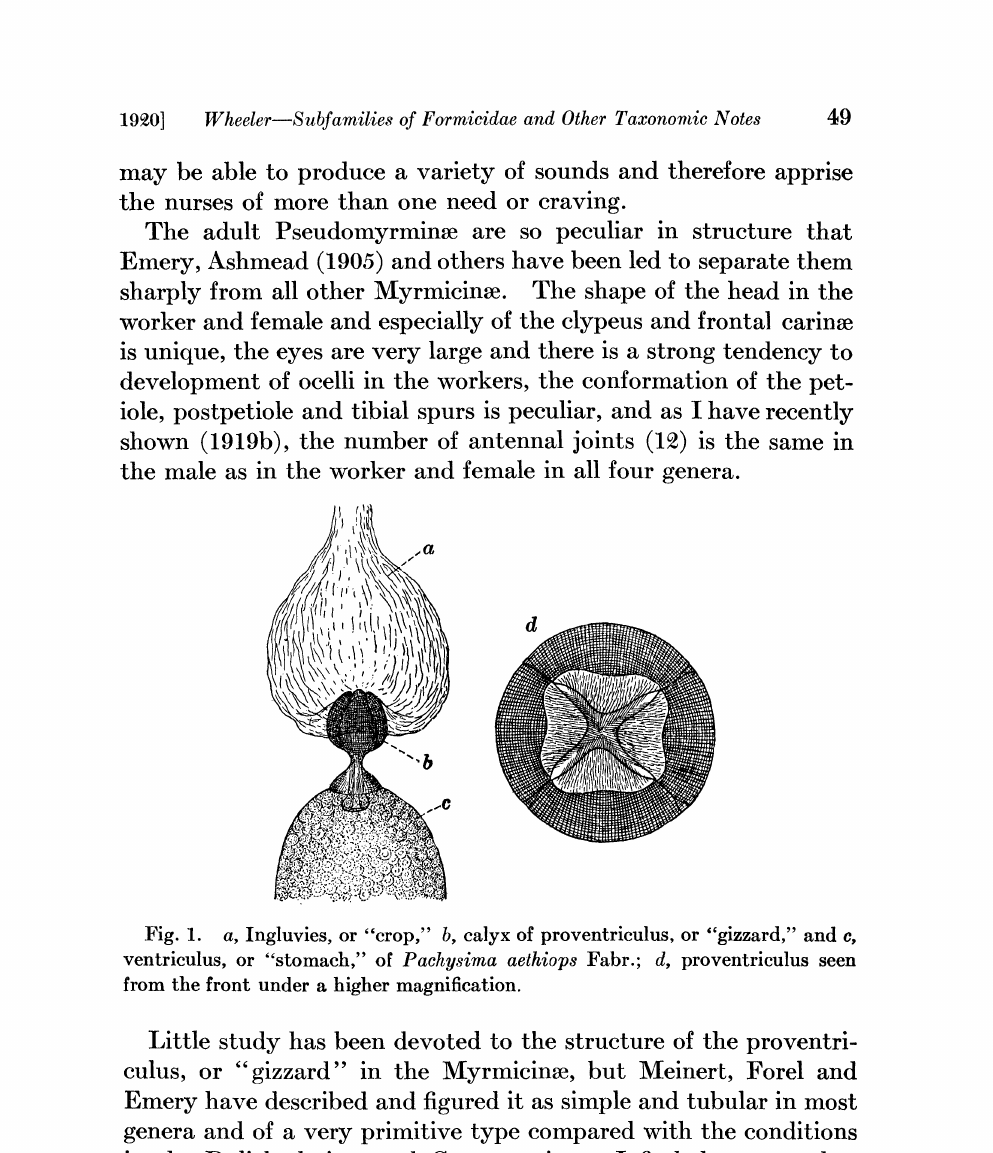
Fig. 1. a, Ingluvies, or "crop," b, calyx of proventriculus, or "gizzard," and c, ventriculus, or "stomach," of Pachysima aethiops Fabr.; d, proventriculus seen from the front under a higher